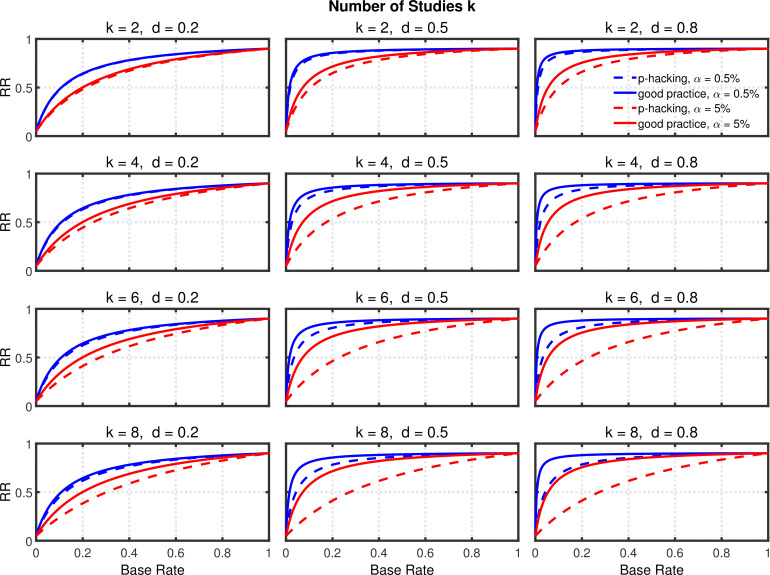
Selective reporting of significant studies.Replication rate (RR) as a function of base rate π, number of studies k, effect size d, and nominal α level (0.5% or 5%). The nominal α level and power of the replication study are α2=5% and 1-β2=90%. All results are based on one-sample tests with n=20.